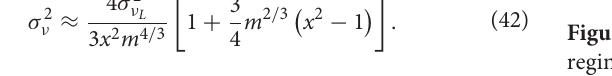
FIGURE 11 | Relative bandwidth as the fixed-bandwidth second laser is stretched for different harmonics, assuming σ z lines, and approximate solutions from Equation (42) are dashed lines. The disagreement with exact solutions is attributed to the super-Gaussian approximation for g ( z